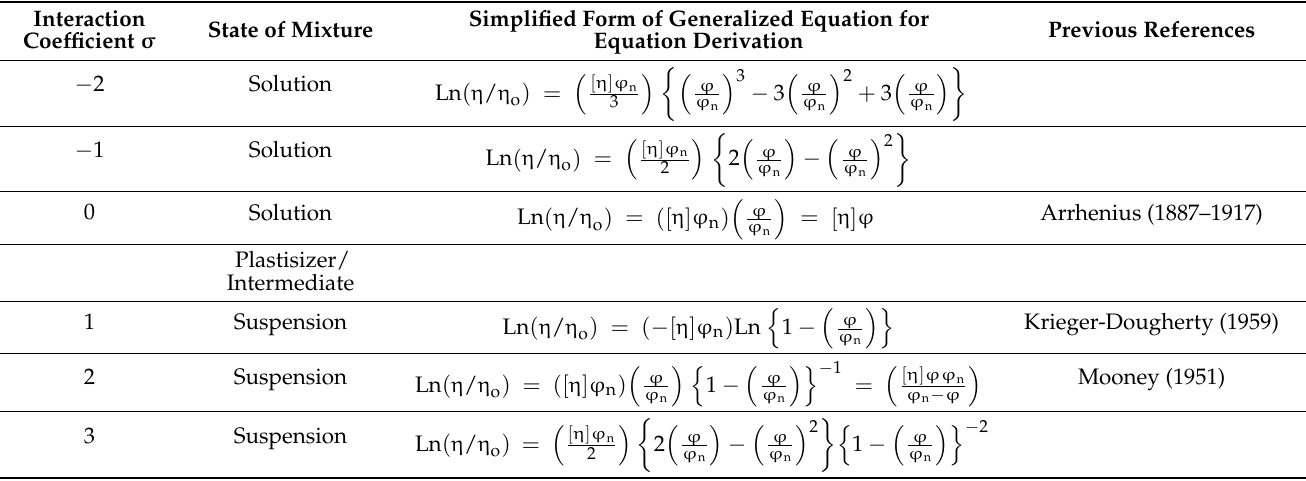
Table 5. Generalized suspension viscosity equation for selected values of the interaction coefficient, σ . Interaction Simplified Form of Generalized Equation for State of Mixture Coefficient σ Equation Derivation